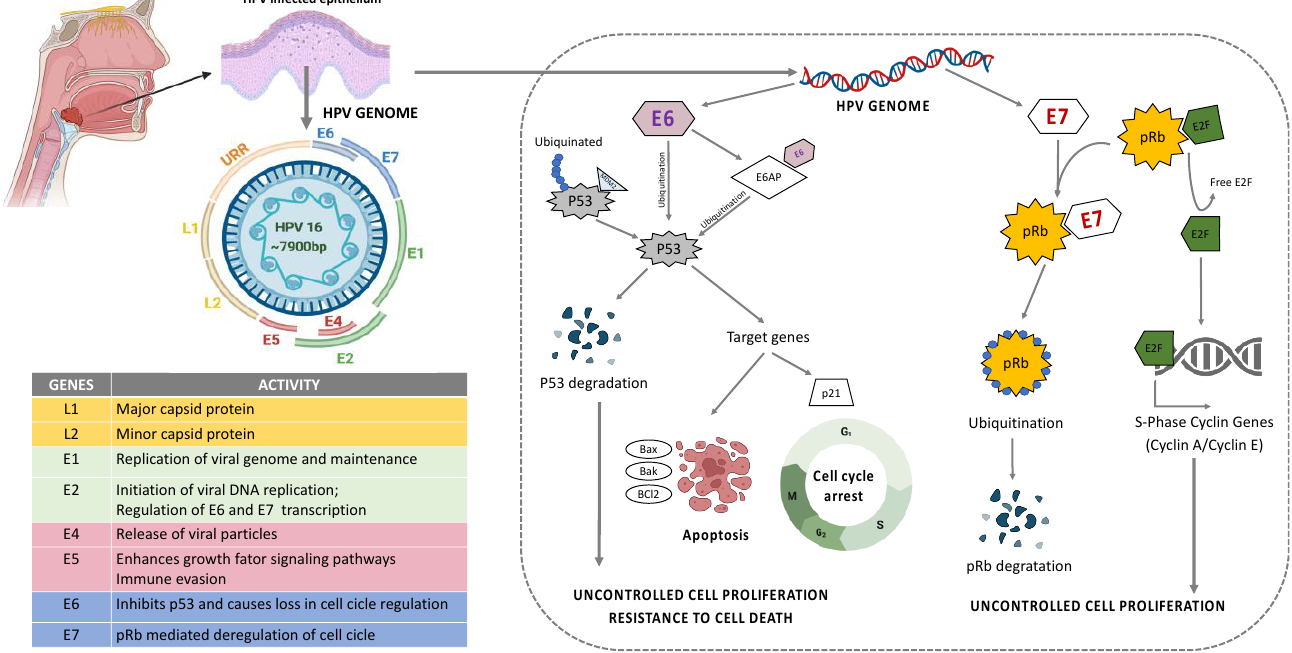
Figure 3. Structure and organization of HPV16 genome. E6 mediated p53 manipulation and E7 mediated inhibition of pRb protein leading to sustained cell proliferation and resistance to apoptotic barrier.